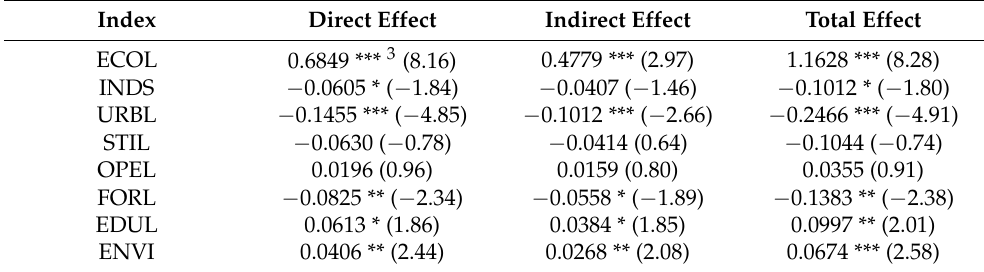
Table 5. Results of the classification of spatial spillover